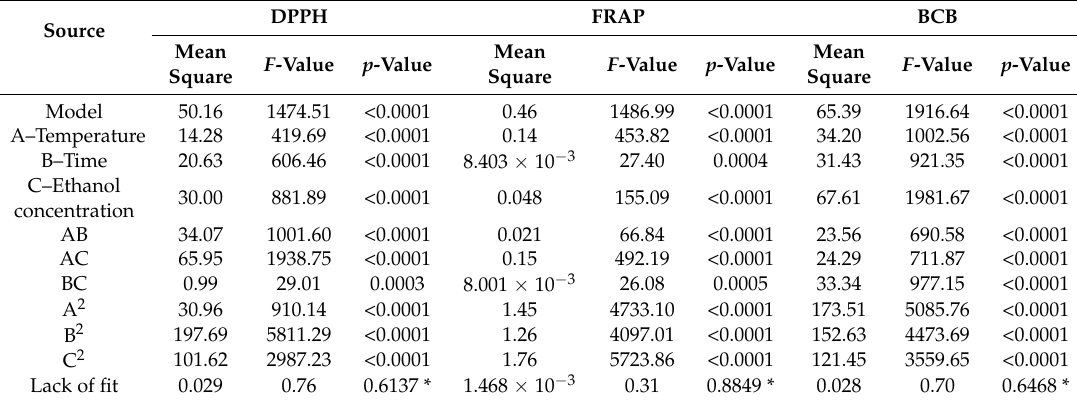
Table 3. The regression coefficients of the predicted quadratic polynomial models for the responses of the DPPH, FRAP, and BCB